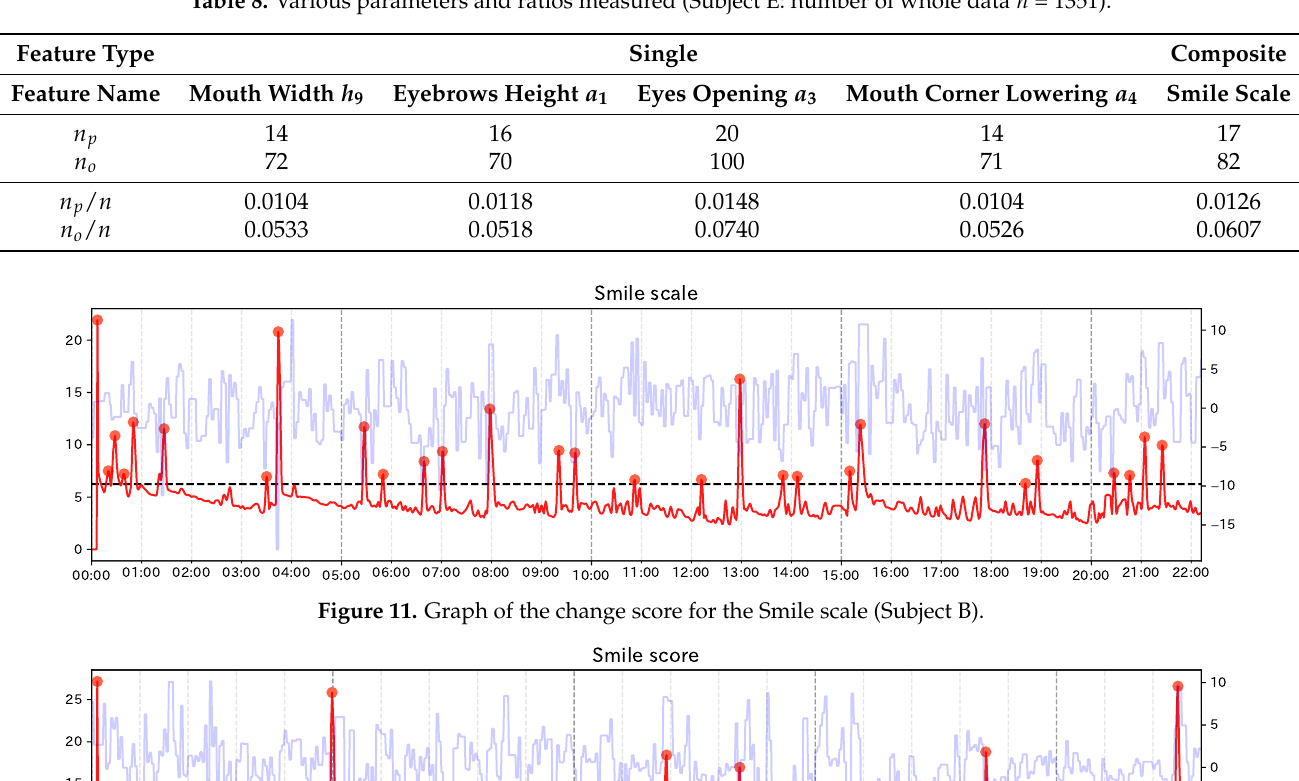
Table 8. Various parameters and ratios measured (Subject E: number of whole data n = 1351).